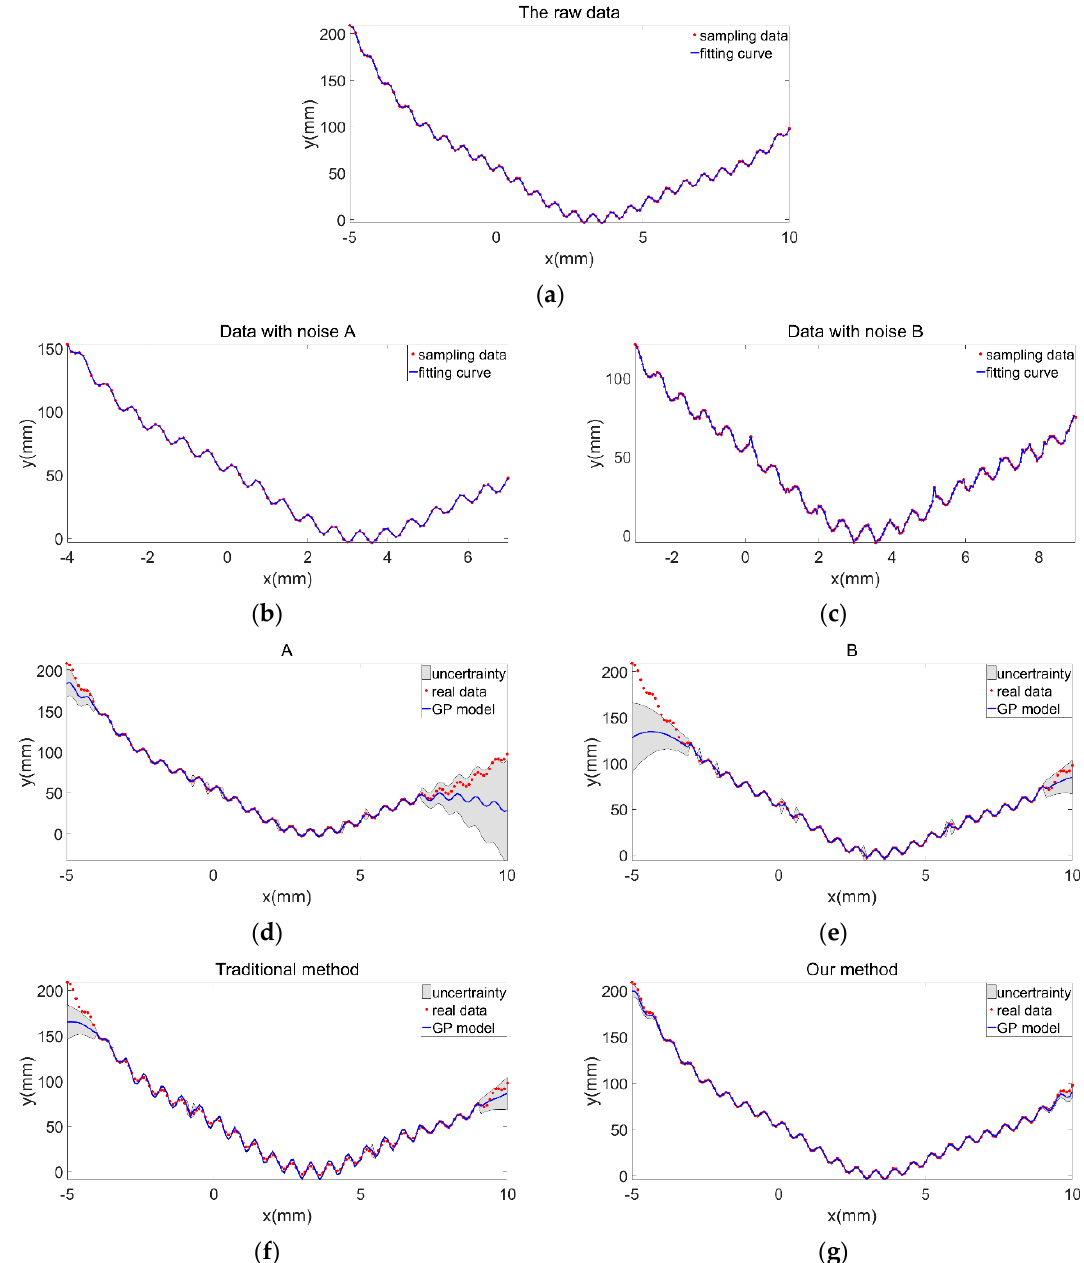
Figure 5. ( a ) Raw data of the curve; sampling data with ( b ) noise A, ( c ) noise B; GPR modeling of curves using ( d ) sampled data with noise A, ( e ) sampled data with noise B, ( f ) the traditional method, and ( g ) the proposed method.